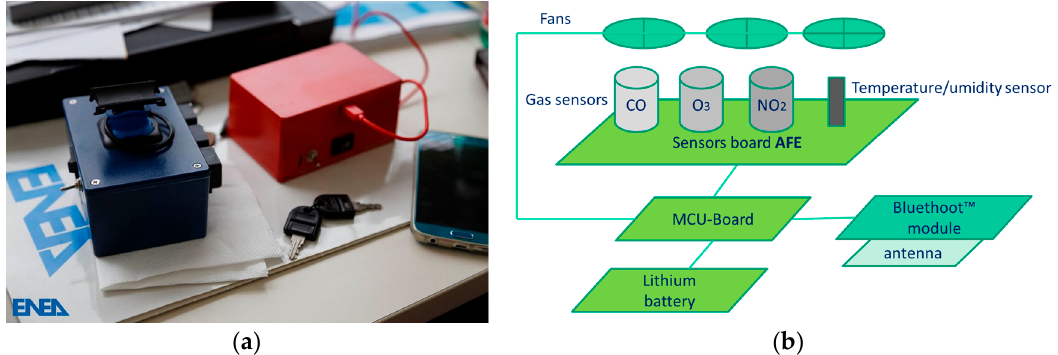
Figure 1. ( a ) Two MONICA 2.0 system prototypes, one of which featuring a bike mounting device and ( b ) the MONICA 2.0 node architectural scheme.